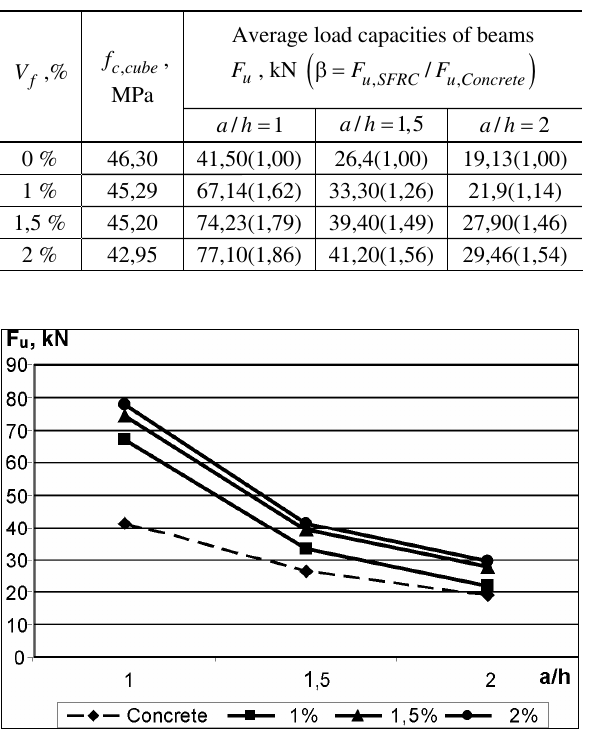
V and shear span ratio f